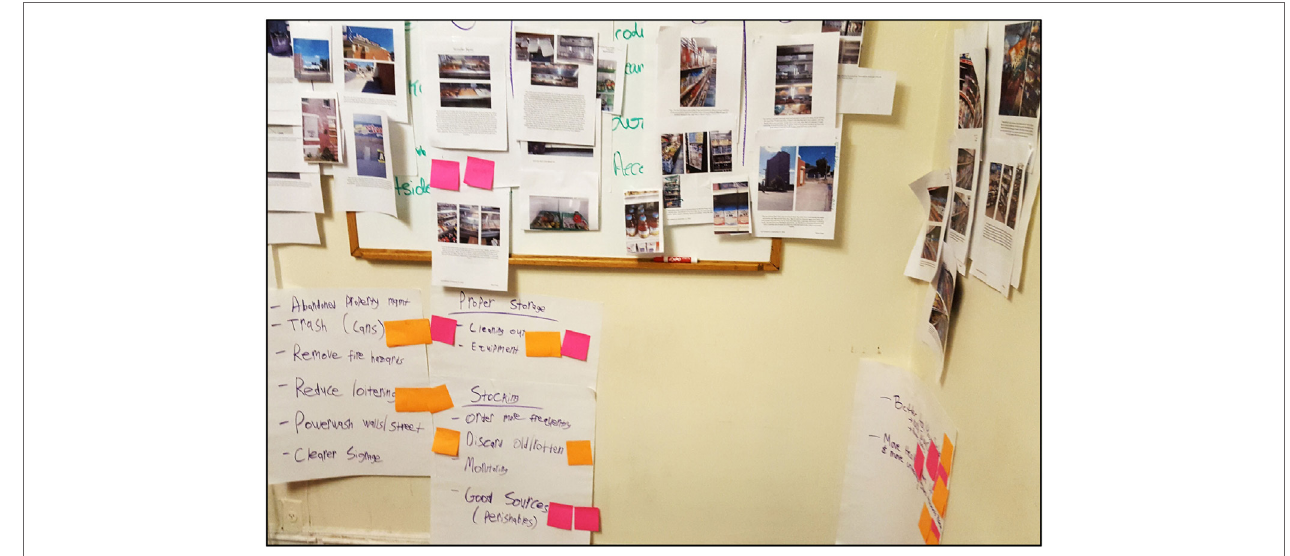
FiguRE 3 | Photograph of theme clusters assembled during Community Meeting 1 in Camden, New Jersey (September